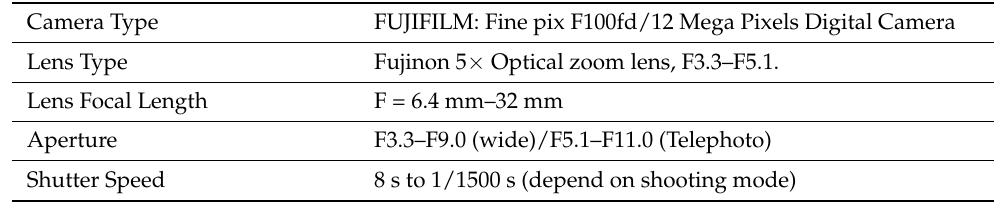
Table 3. Geometric parameters of the digital camera.